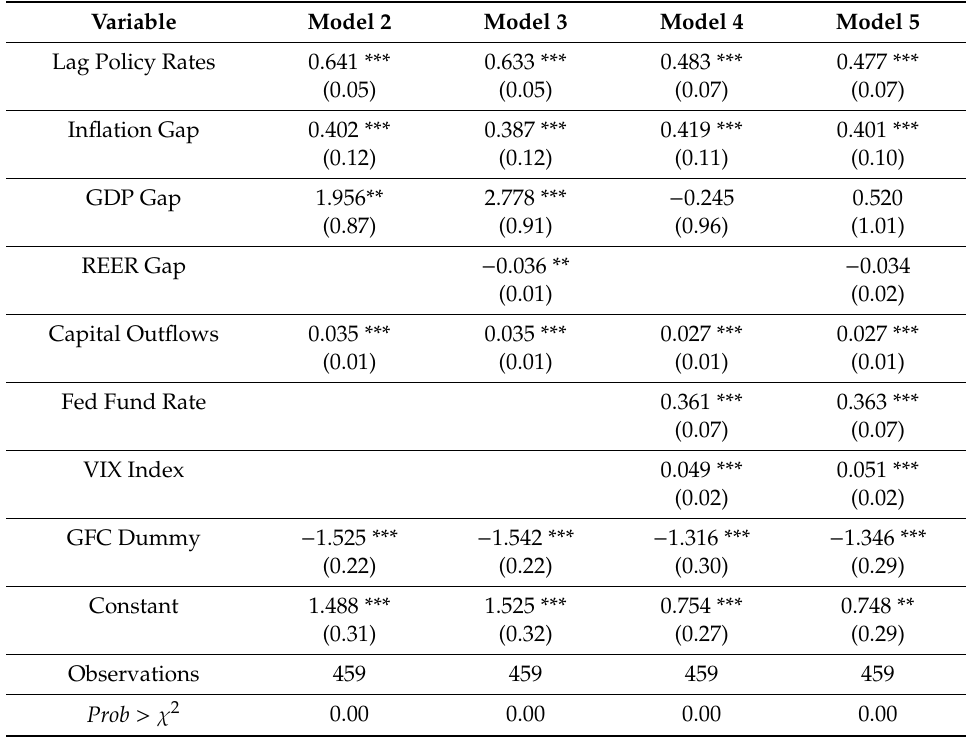
Table 5. The Augmented Taylor Rule with Capital Outflows and GFC